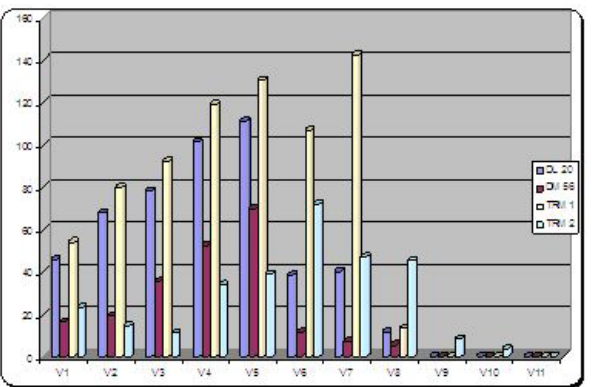
Fig. 3. Variation of normal embryo number yielded at different values of pH